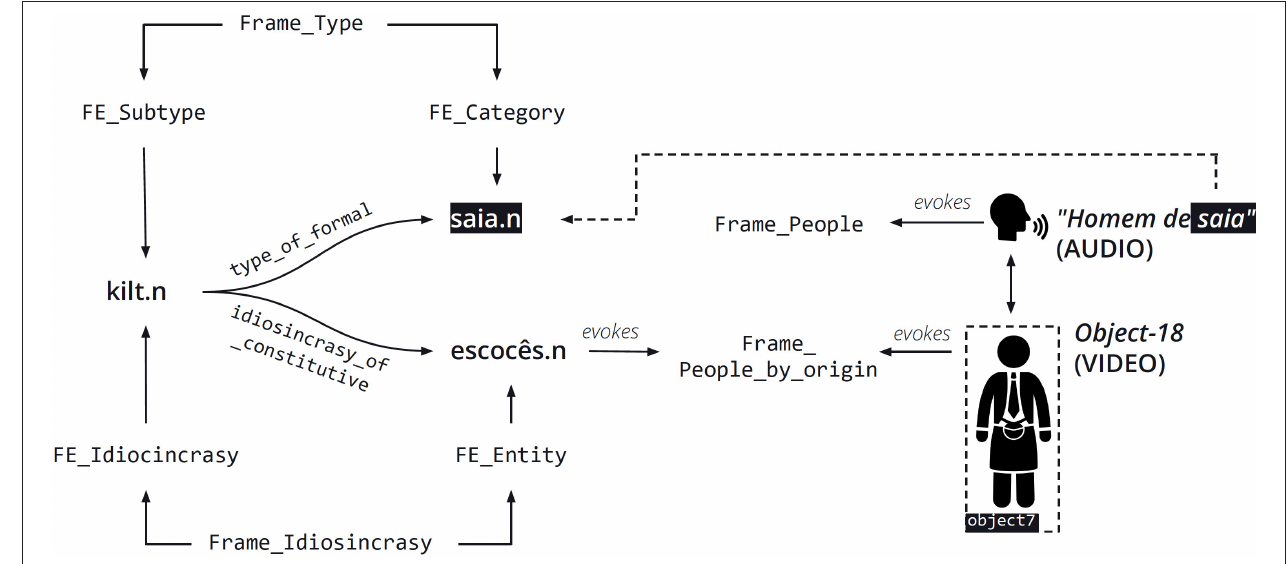
FIGURE 10 | Frame-mediated ternary qualia relations for homem de saia.n and object 18. Reproduced with permission from Belcavello et al. (2020).